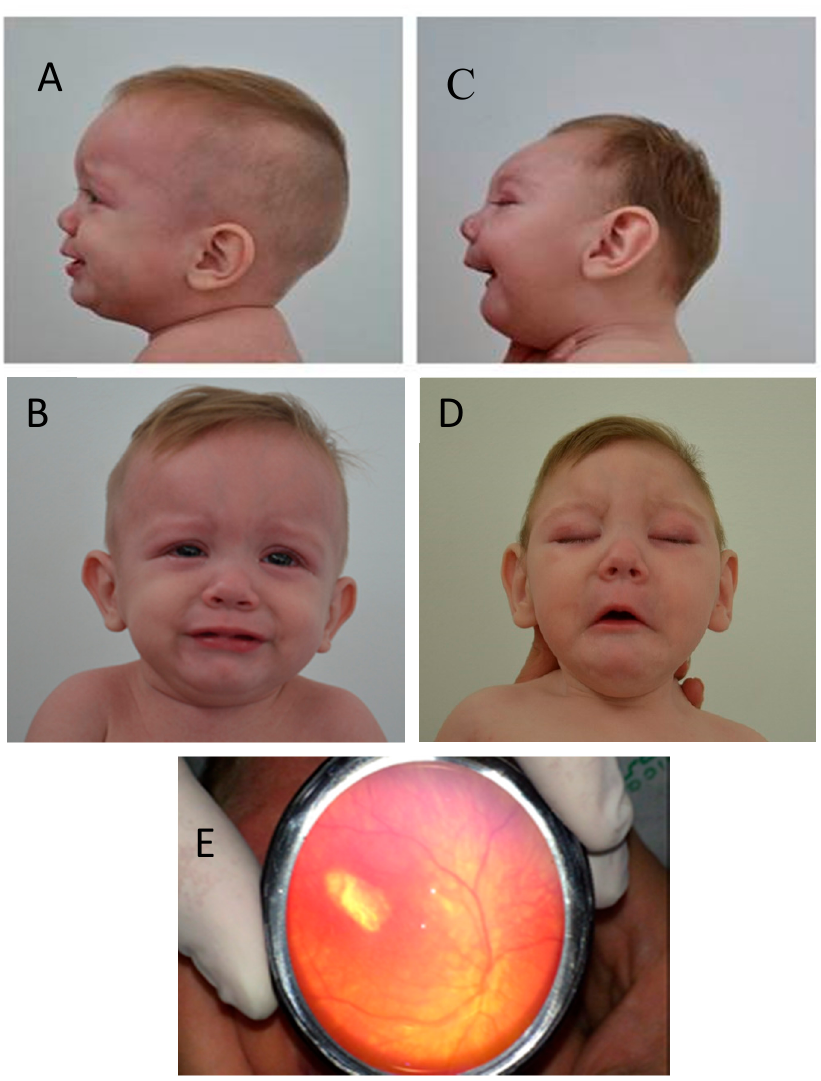
Figure 3. Comparative clinical characteristics of monozygotic dichorionic-diamniotic twins discordant for congenital Zika virus outcomes.